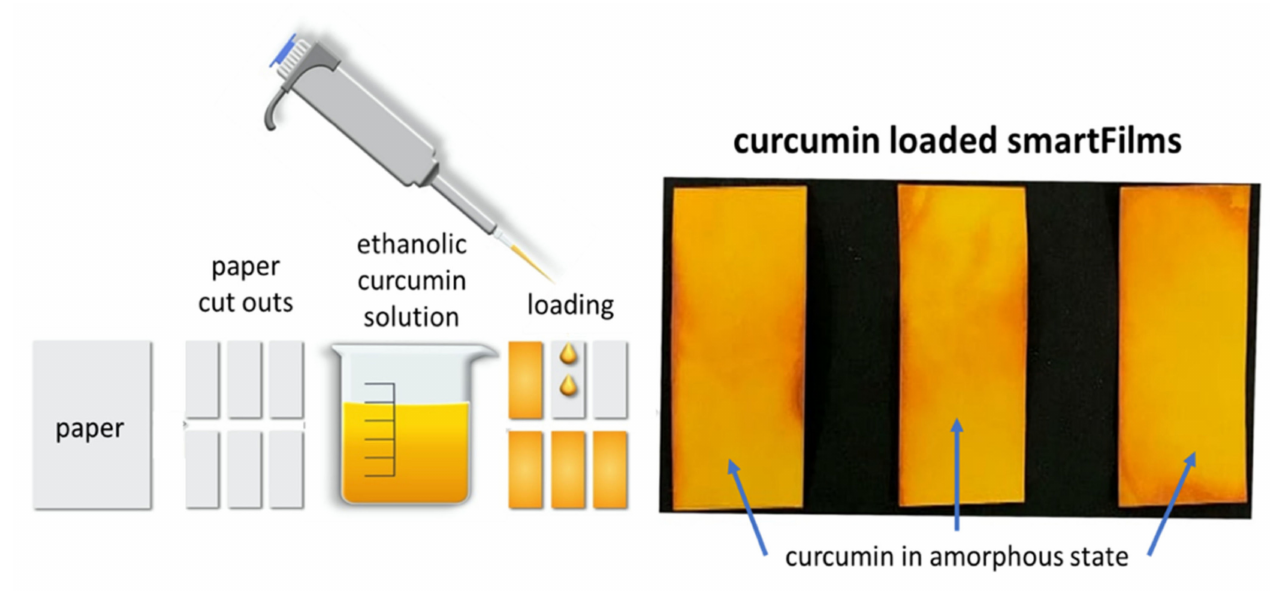
Figure 1. Scheme of smartFilm